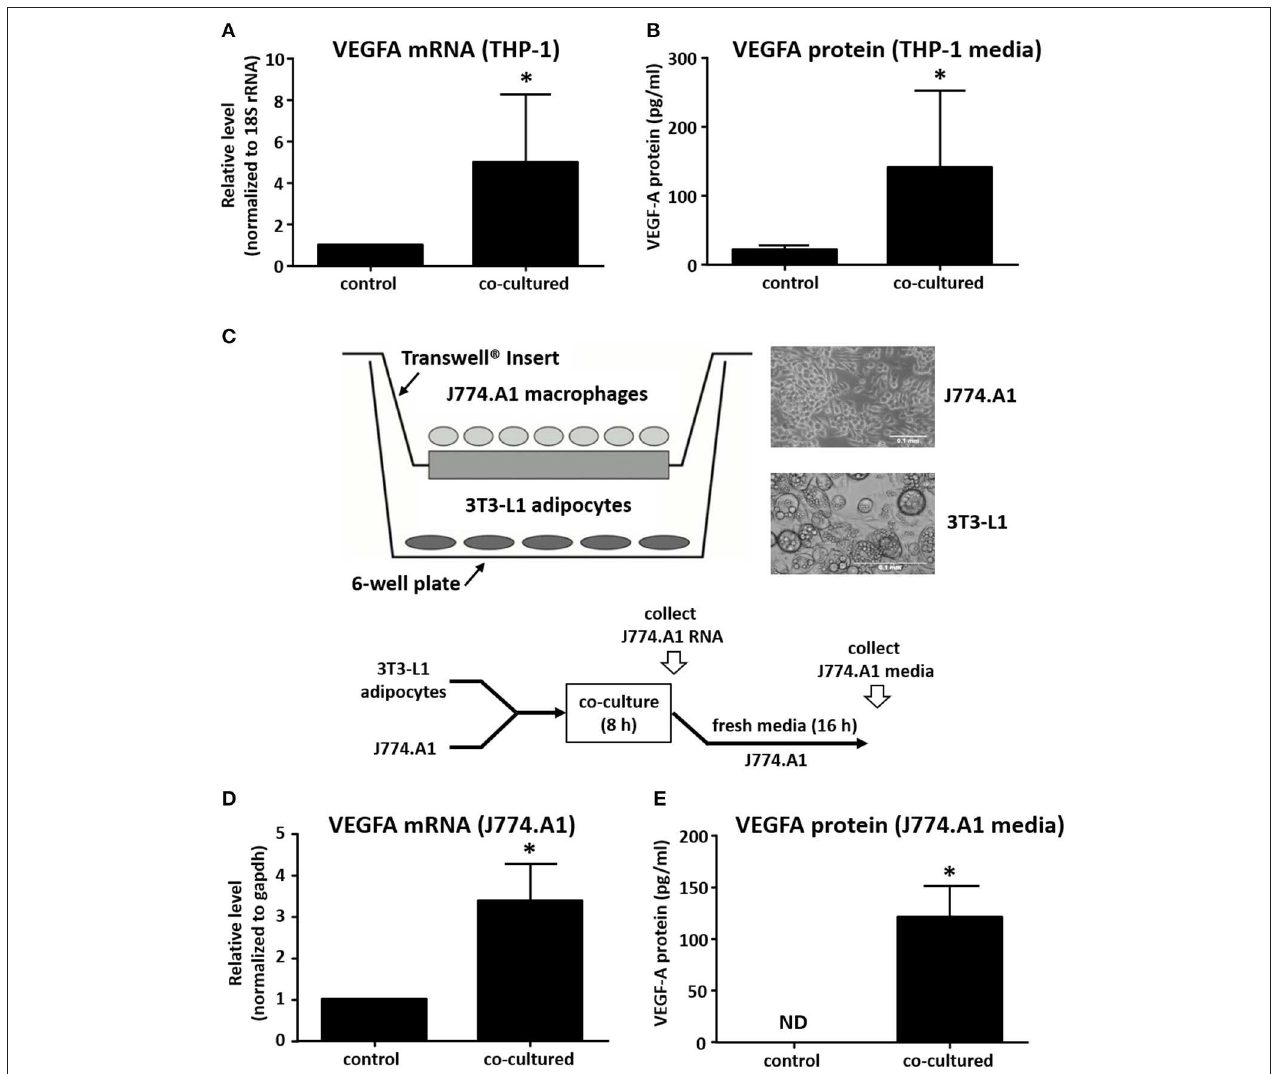
FIGURE 2 | Co-culture with adipocytes stimulates expression of VEGF in macrophages. (A) Differentiated primary human breast adipocytes were co-cultured with PMA-differentiated THP-1 cells using a Transwell system for 8h before RNA was collected, reverse transcribed, and qPCR performed with 18S and VEGFA primers. (B) THP-1 were co-cultured with breast adipocytes as above for 8h then changed to fresh media for an additional 16h, then supernatant was collected and analyzed for secreted VEGFA protein. (C) Diagram showing co-culture system where murine adipocytes were cultured in the lower chamber and murine macrophages were cultured on a Transwell insert, co-culture was performed for 8h. (D) Macrophage RNA was collected after 8h of co-culture, reverse transcribed, and qPCR performed with GAPDH and VEGFA primers. (E) J774A.1 murine macrophages were co-cultured with differentiated 3T3-L1 murine adipocytes as above for 8h then changed to new media for 16 additional h before supernatant was collected and analyzed for secreted proteins ( n = 4, * p < 0.05); ND, not detected; statistical analyses were performed using standard deviation and the unpaired Student’s t